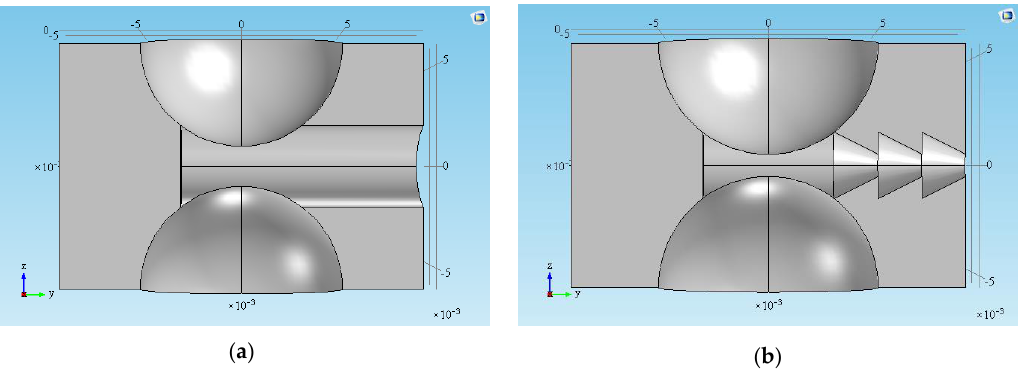
Figure 5. Structures of the basic SSAC and the optimized SSAC: ( a ) basic SSAC [6]; ( b ) optimized SSAC.